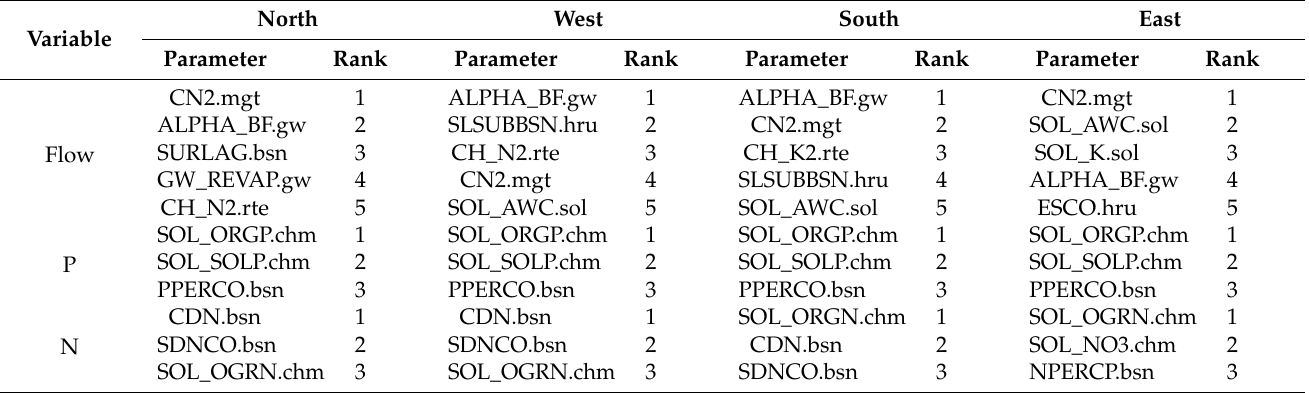
Table 3. Parameter sensitivity analysis of SWAT model in Lake